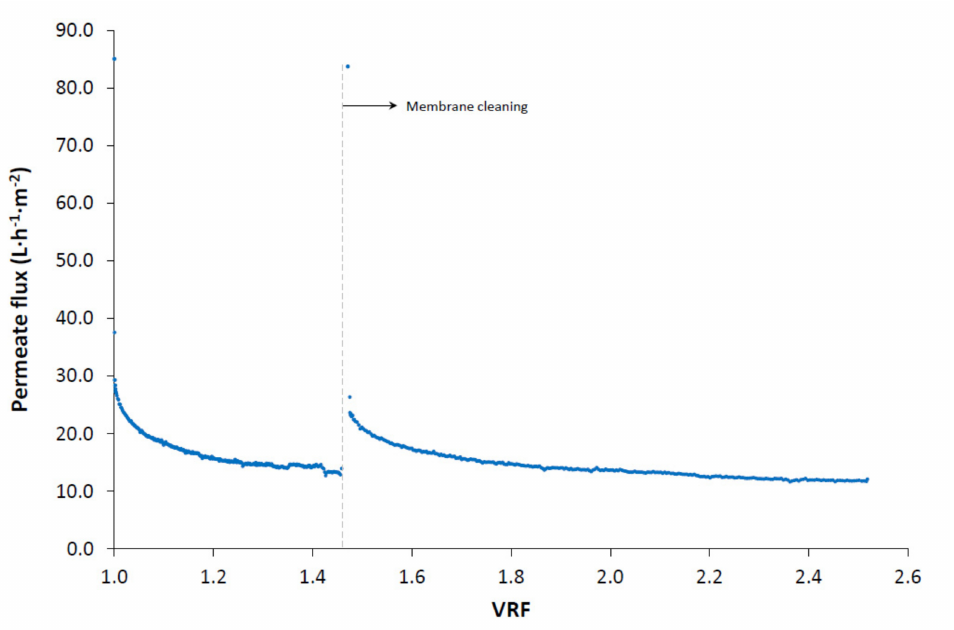
Figure 5. Evolution of permeate flux during the ultrafiltration step as a function of the volume reduction